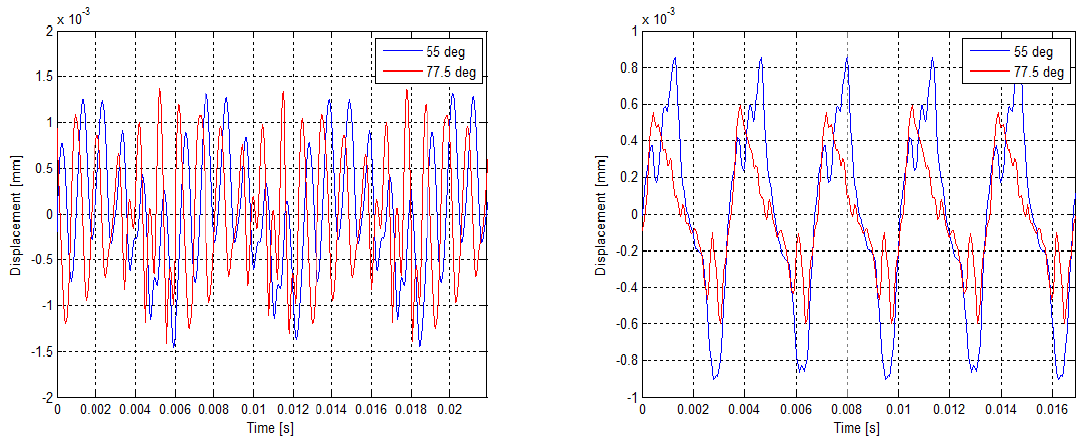
Figure 5. Vibration of the stator at specific point for two different current angles at two rotational speeds: 600 rpm ( left ) and 4500 rpm ( right ) .